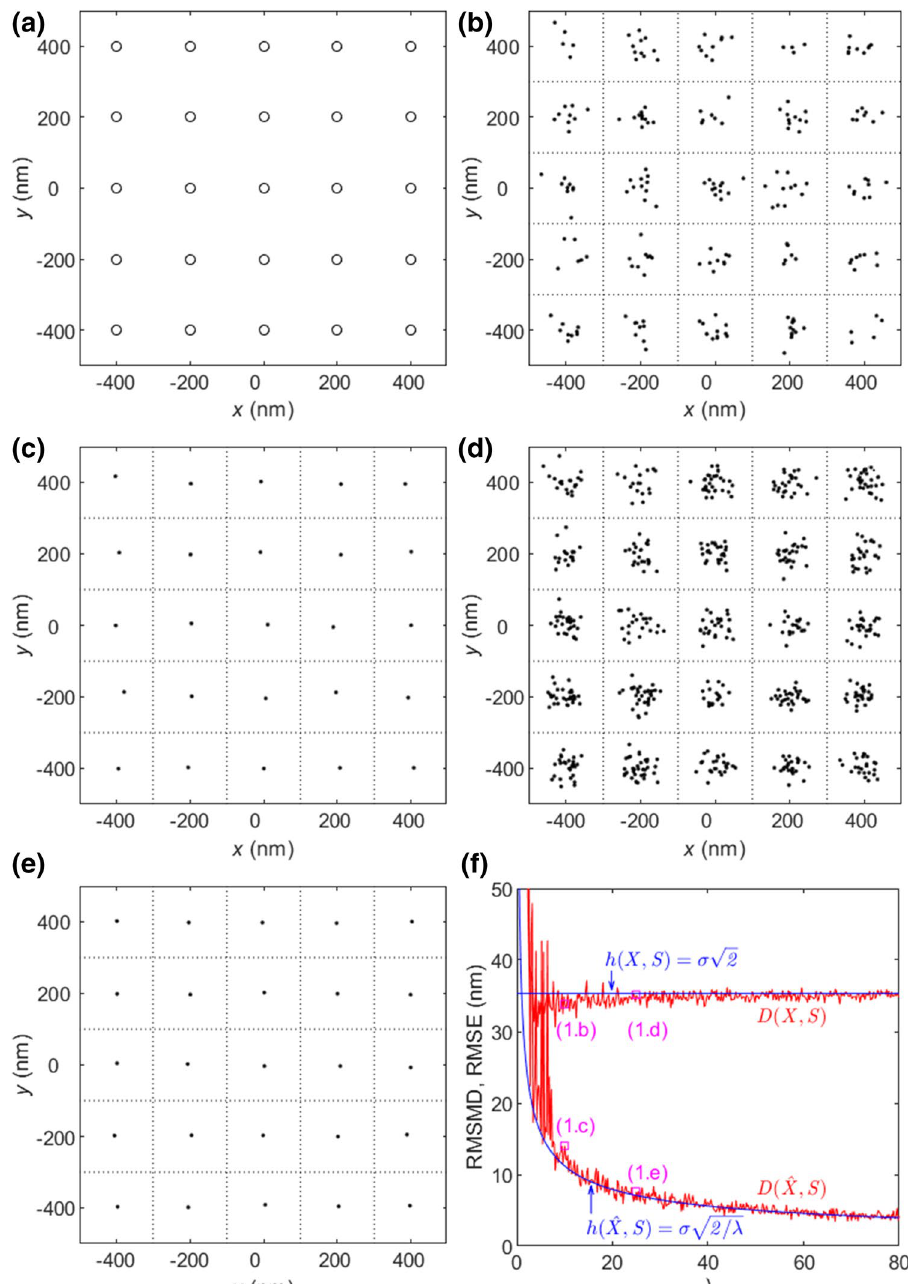
Figure 1. Effect of (cid:31) and the maximum folds of RMSMD and RMSE improvements by exploitation of temporal correlation with zero bias and σ averaging from ( b ). ( d ) X with (cid:31) are denoted by the dotted lines. ( f ) RMSMDs and RMSEs of X and ˆ X versus (cid:31) . The RMSMDs of (1.b)-(1.e) are denoted by the